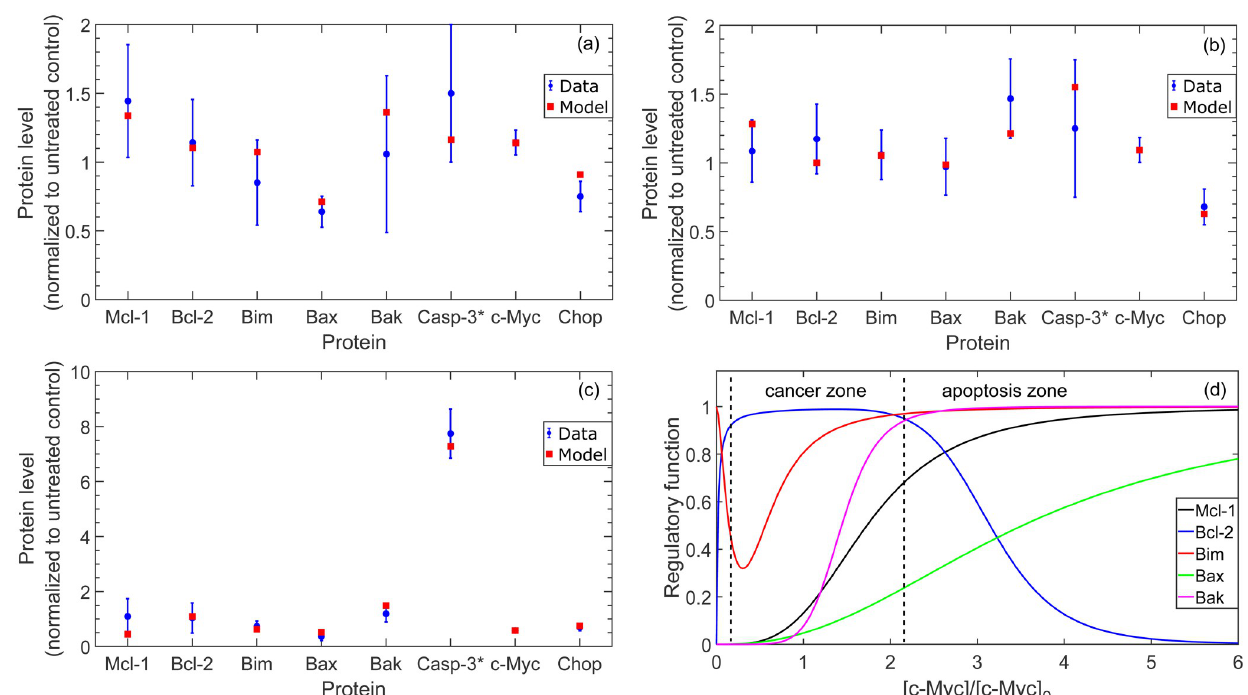
Fig 3. Simulated protein expression levels at t = 72 hour in comparison to experimentally-measured protein expression in MOLM-13 R2 cells. Blue circles correspond to the average of experimental measurements and error bars correspond to one standard deviation. Plots illustrate total protein expression levels for Mcl-1, Bcl-2, Bim, Bax, Bak, c-Myc, and Chop, and active Caspase-3 levels only. All protein levels are normalized to the expression in the untreated system. (a) 400 nM venetoclax monotherapy, (b) 5,000 nM tedizolid monotherapy, (c) 400 nM venetoclax and 5,000 nM tedizolid combination therapy administered simultaneously. (d) Shows the predicted c-Myc-dependent regulatory functions for each Bcl-2 family protein in the model, normalized by the transcription factor-dependent maximal production rate for each protein. The boundaries separating distinct zones are illustrative and were chosen as approximately the concentration of c-Myc that separates states where pro-apoptotic c-Myc-dependent regulatory functions are predominantly saturated from states where the anti-apoptotic c-Myc-dependent regulatory functions are predominantly saturated (see Eqs. (A.18)- (A.22) in S1